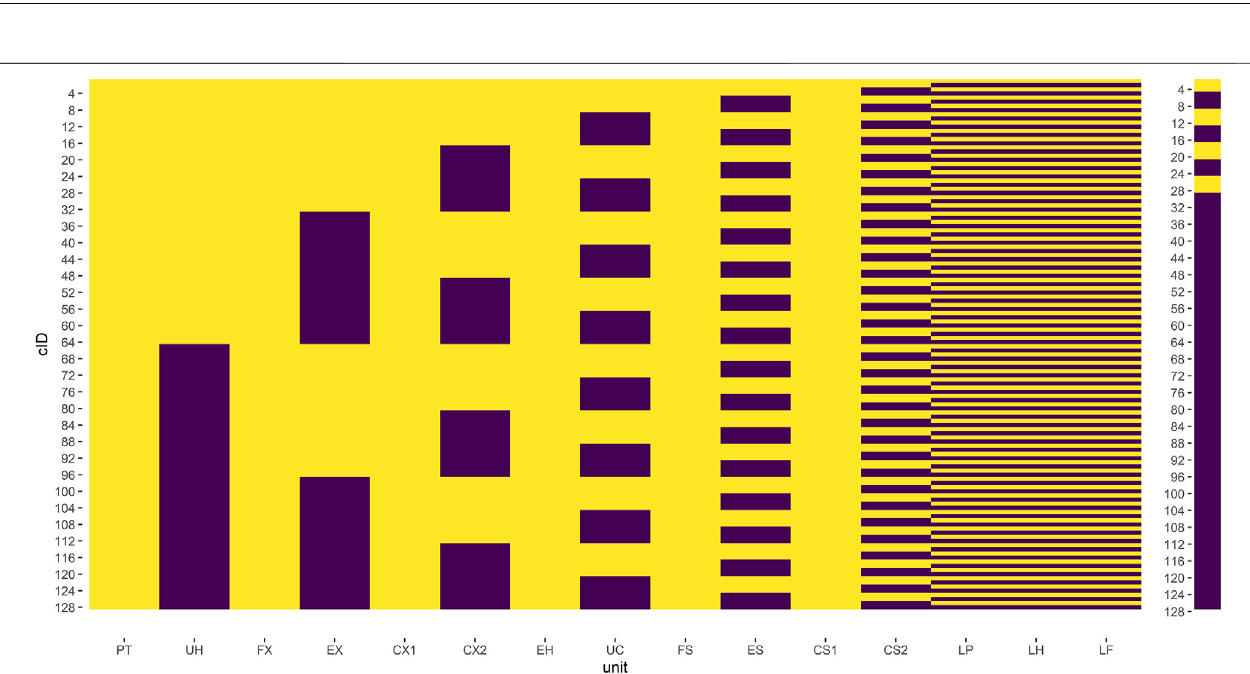
FIGURE3| Feasibilitymatrixofthecoarse sampling, displayingtheexistence(yellow) orabsence(blue)ofeach unitoperationineach con fi guration ID,withthelast column indicating the feasibility (yellow) or infeasibility (blue) of the fl owsheet.